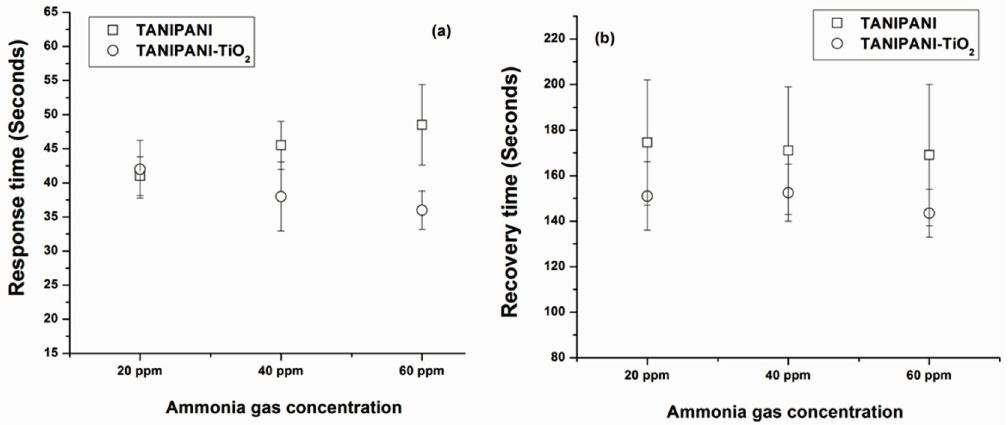
Figure 9. ( a ) Response times of TANIPANI-TiO 2 sensors after exposure to 20 ppm, 40 ppm and 60 ppm of ammonia gas; ( b ) Recovery times of TANIPANI-TiO 2 samples after withdrawing 20 ppm, 40 ppm and 60 ppm of ammonia gas.